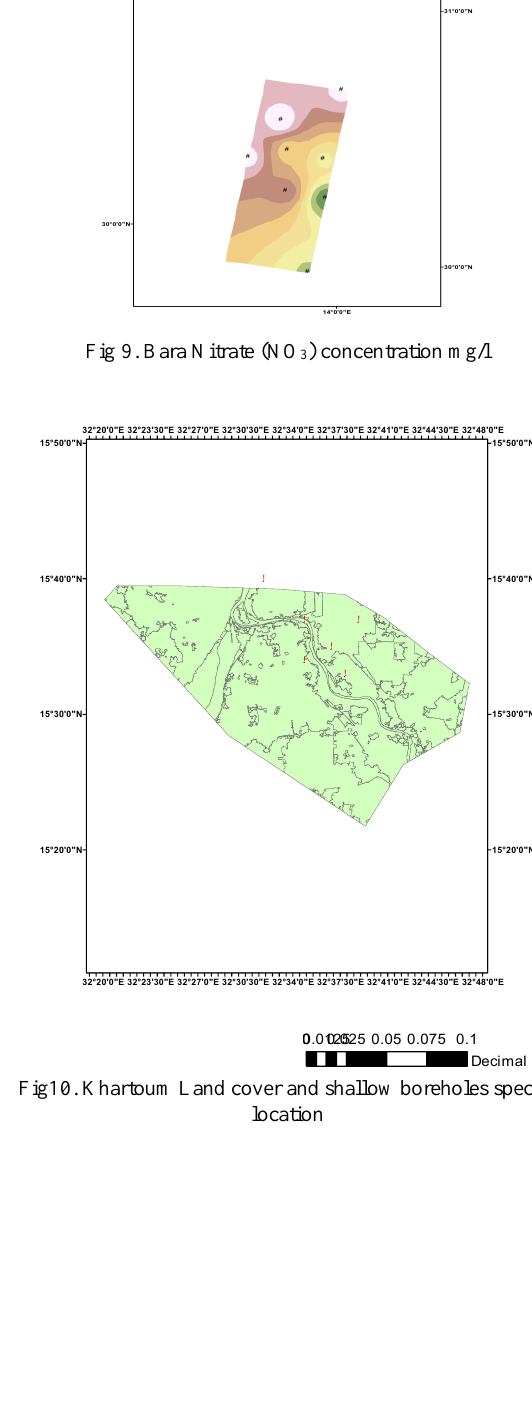
Fig 8. Bara salinity map